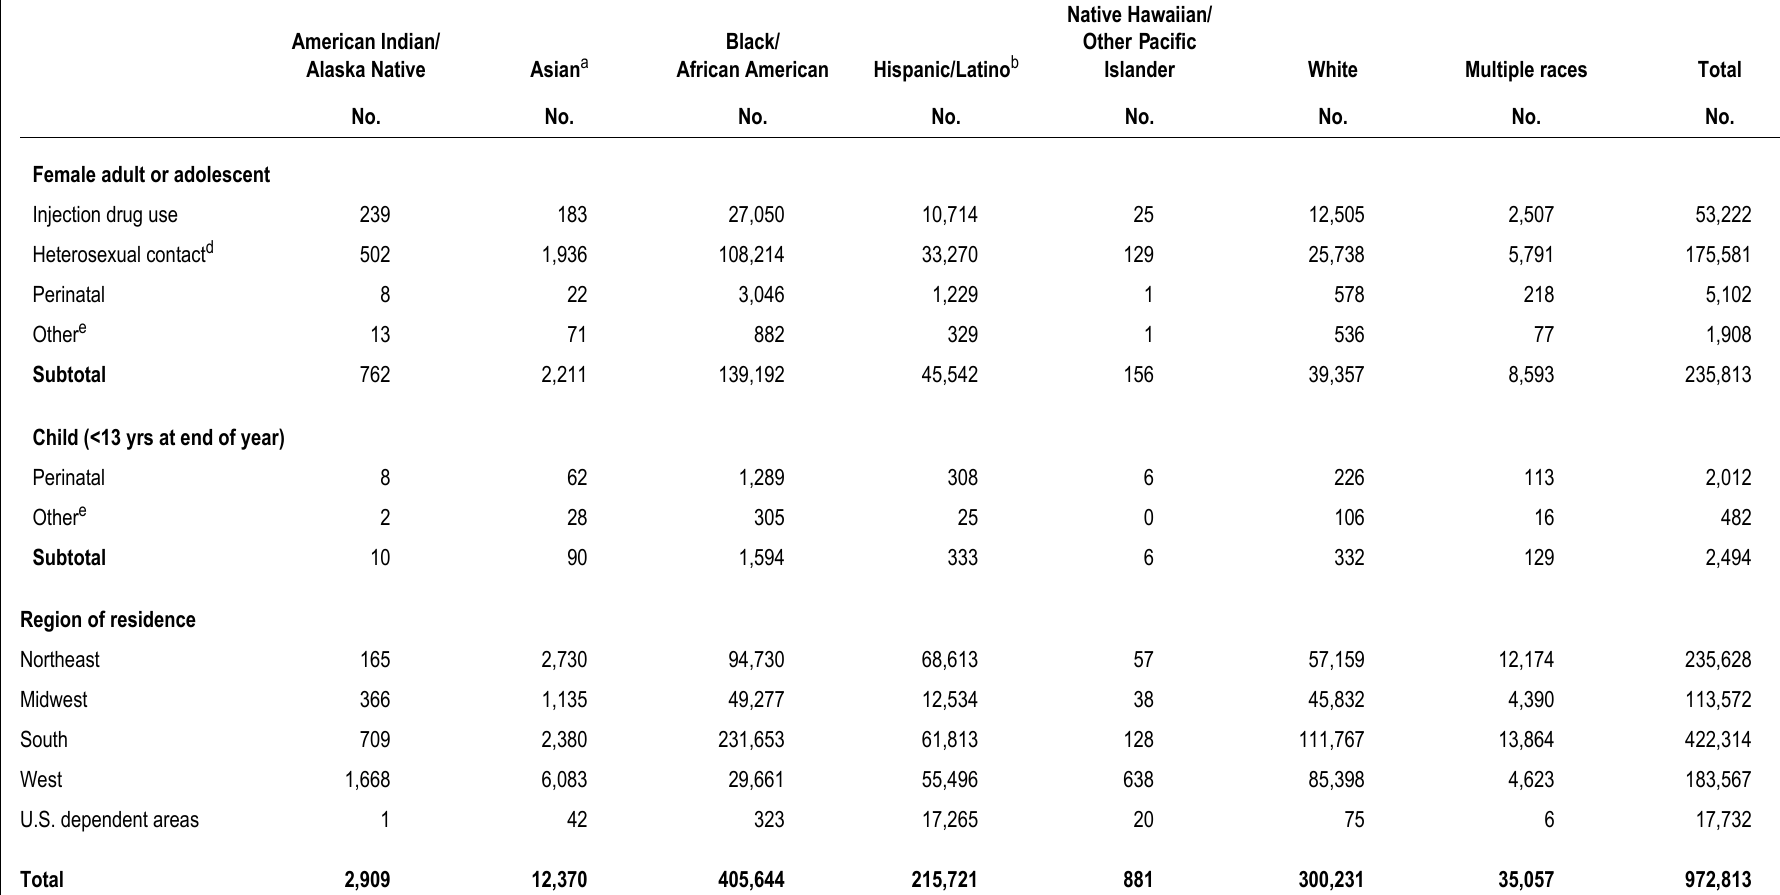
Table 20b. Persons living with diagnosed HIV infection, by race/ethnicity and selected characteristics, year-end 2014—United States and 6 dependent areas